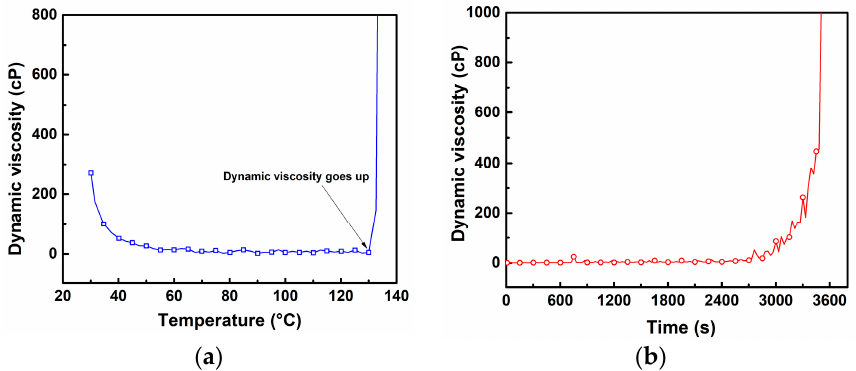
Figure 3. Dynamic viscosity of Derakane Momentum 470-300 resin: ( a ) uncured resin as a function of temperature and ( b ) during curing as a function of time.